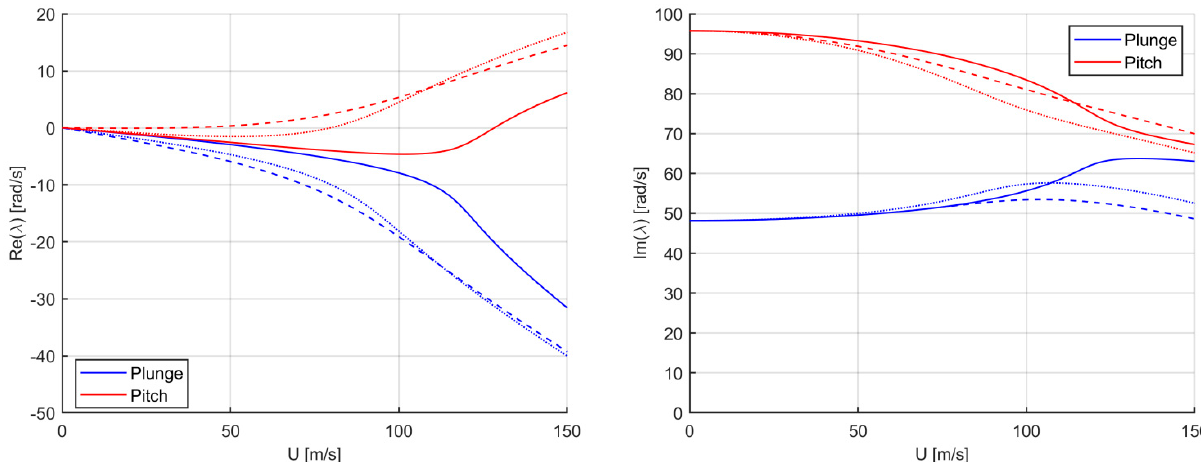
Figure 10. Evolution of the complex eigenvalues for Goland’s wing: real part ( left ), imaginary part ( right ); continuous, dashed and dotted lines for QU, QS and SQS aerodynamic models, respectively.